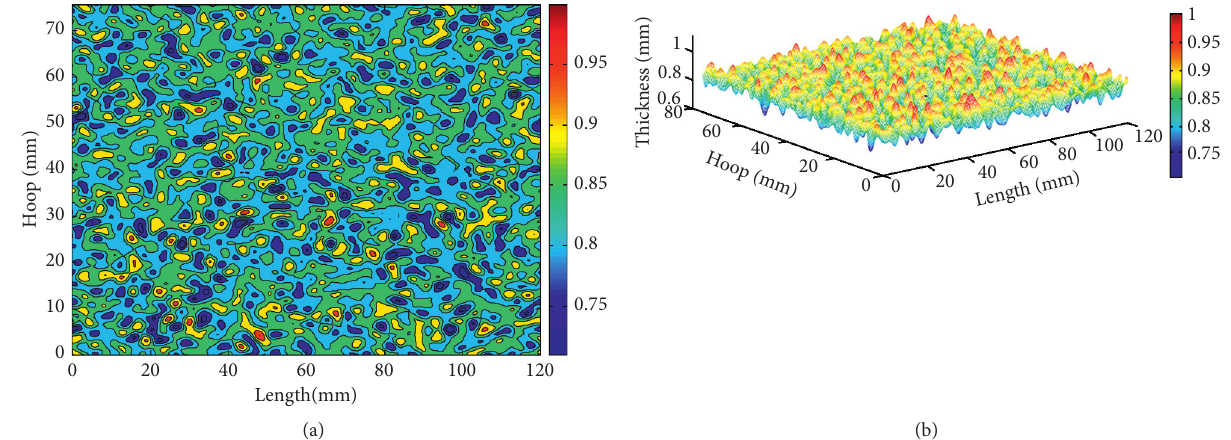
Figure 2: Generated random field of wall thickness along with the axial and hoop directions of a pipe with η � 15% and var � 0 . 06 mm. (a) 2D. (b)